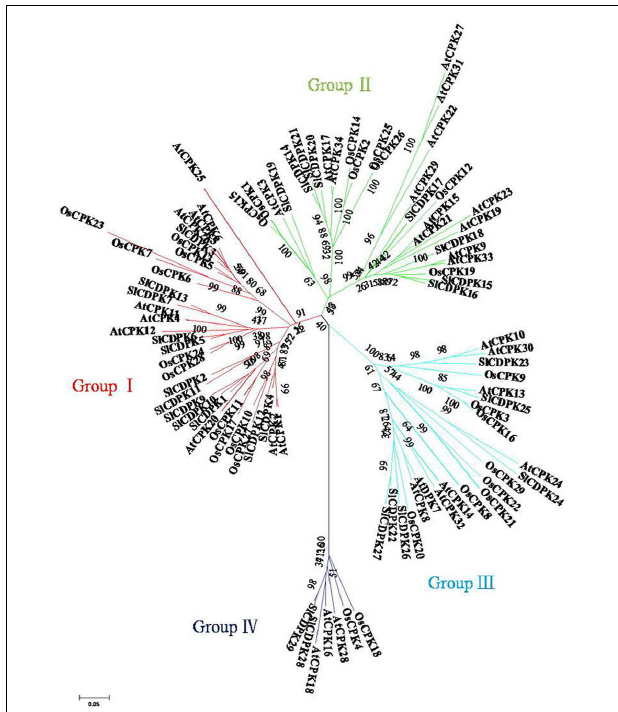
FIGURE 2 | Phylogeny and distribution of CDPK proteins from Arabidopsis , rice, and tomato. Methods follow neighbor-joining with 1000 bootstrap in MEGA 5.0 according to full length amino acid sequences of 29 tomato, 34 Arabidopsis , and 29 rice CDPKs.